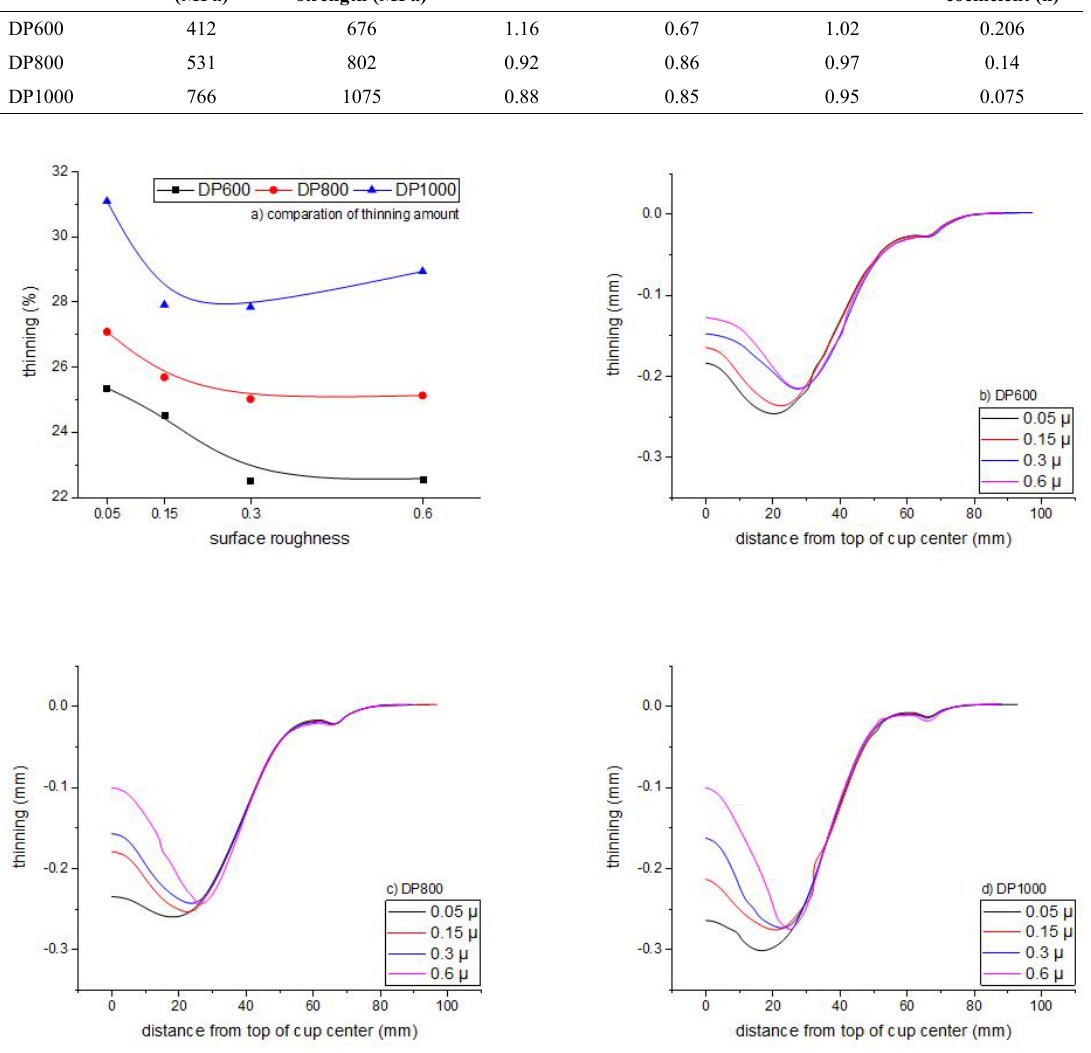
Figure 3. Thinning - friction coefficient